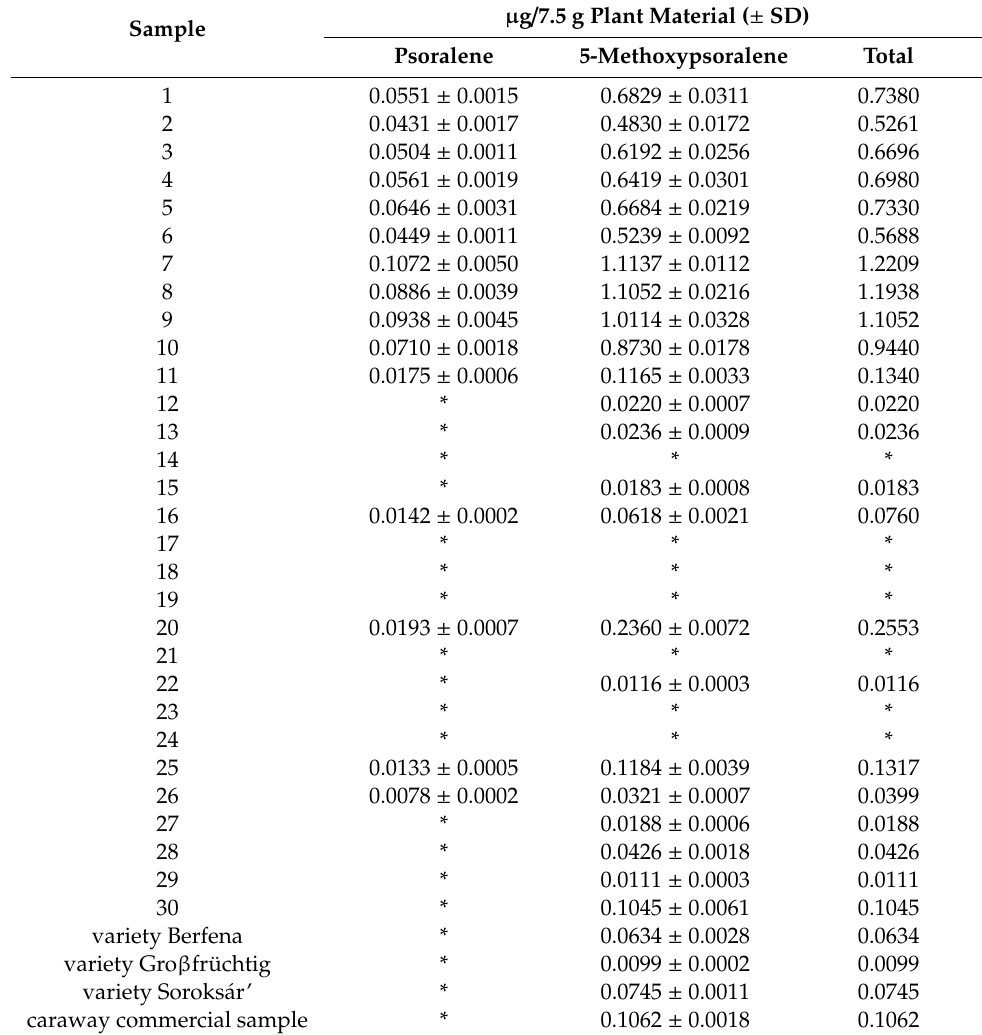
Table 2. Furocoumarin contents of fennel fruit